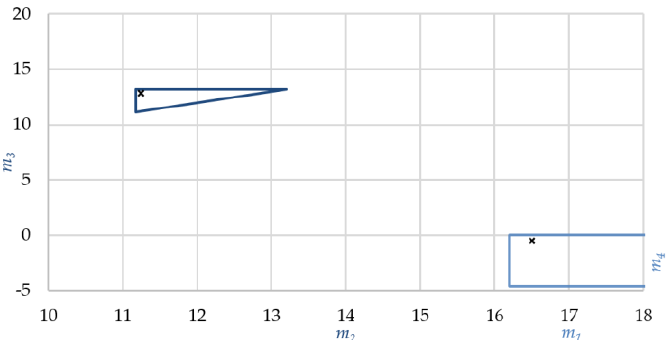
Figure 15. Working diagram for the 4-zone SMB separation where x represents the working point. The separation triangle is in dark blue and the regeneration area is in light blue.